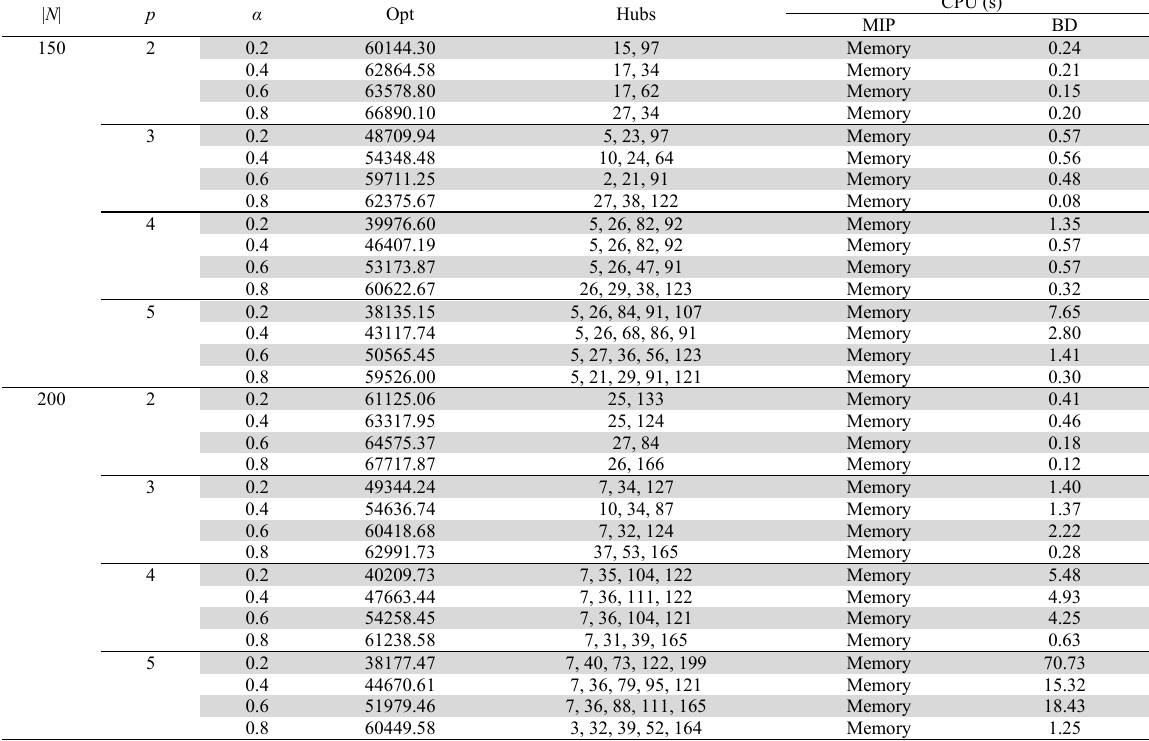
Results for solving the problem for the AP data set (large